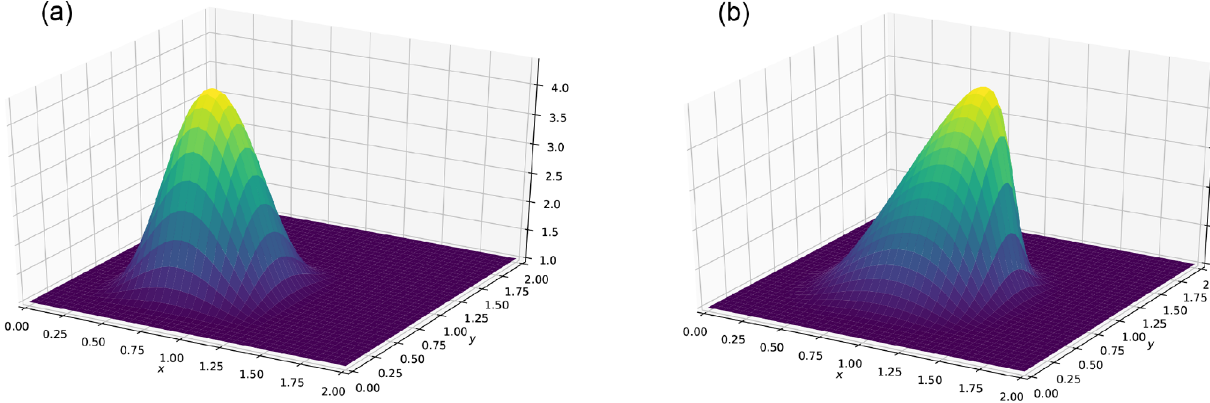
Figure 17. Initial (a) and final (b) time of the simulation of the Burgers’